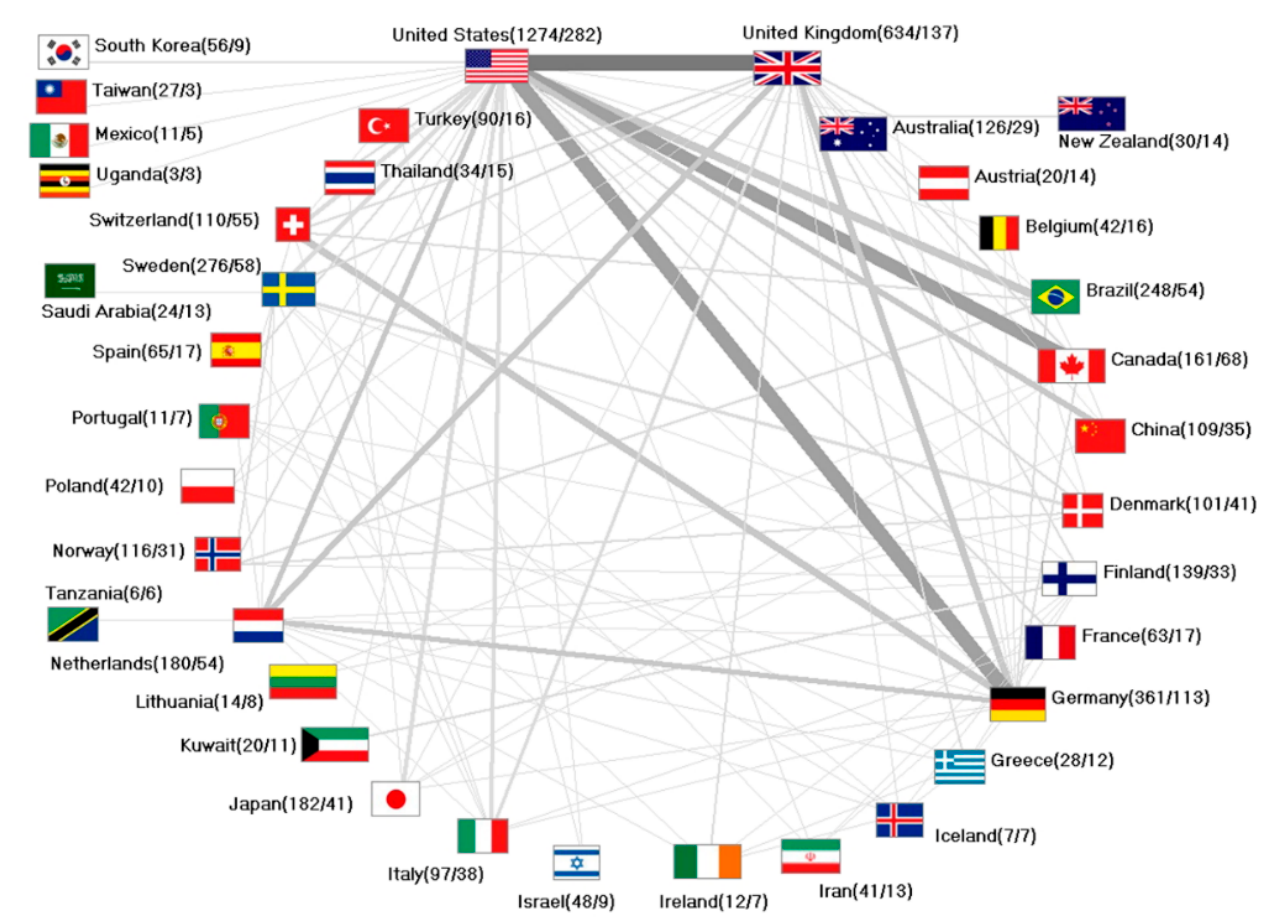
Figure 4. International network on oral hygiene. Numbers in brackets = number of articles/number of cooperation articles.